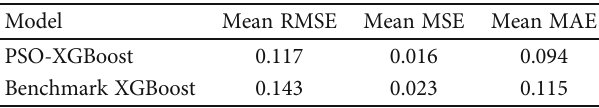
Table 2: XGBoost model error index comparison before and after PSO optimization.